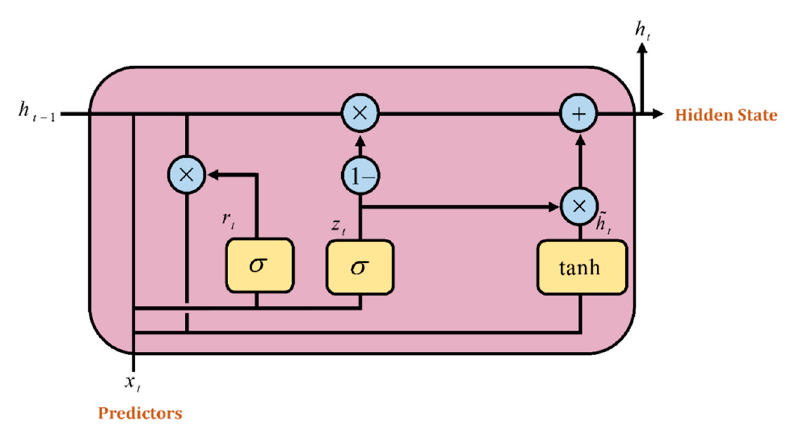
Figure 4. Gated Recurrent Unit (GRU) gates.